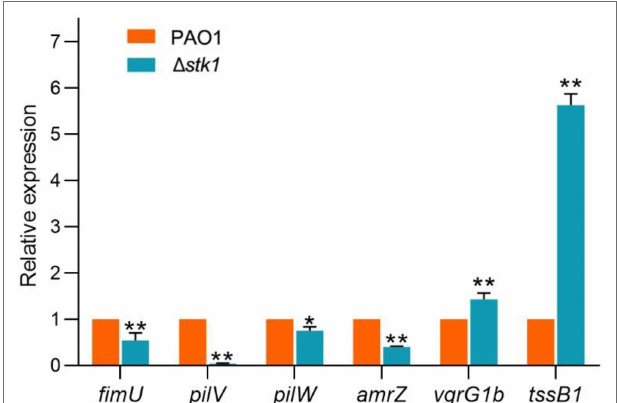
FIGURE 11 | Relative expression of several differentially expressed proteins ( Δ stk1 /PAO1) at the mRNA level determined by qPCR. The data are expressed as the means (SD). The asterisks on the bars indicate that the results were significantly different from the results obtained with the wild-type strain (* p < 0.05 and ** p <